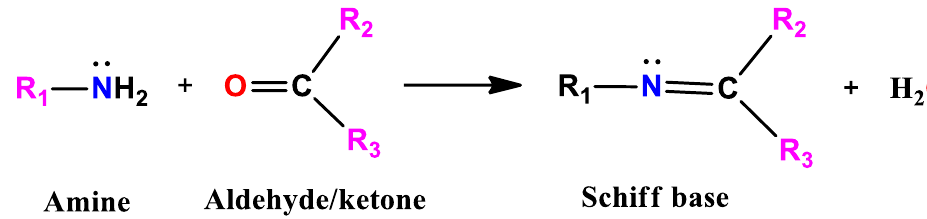
Figure 1. The obtaining reaction for the Schiff-bases.